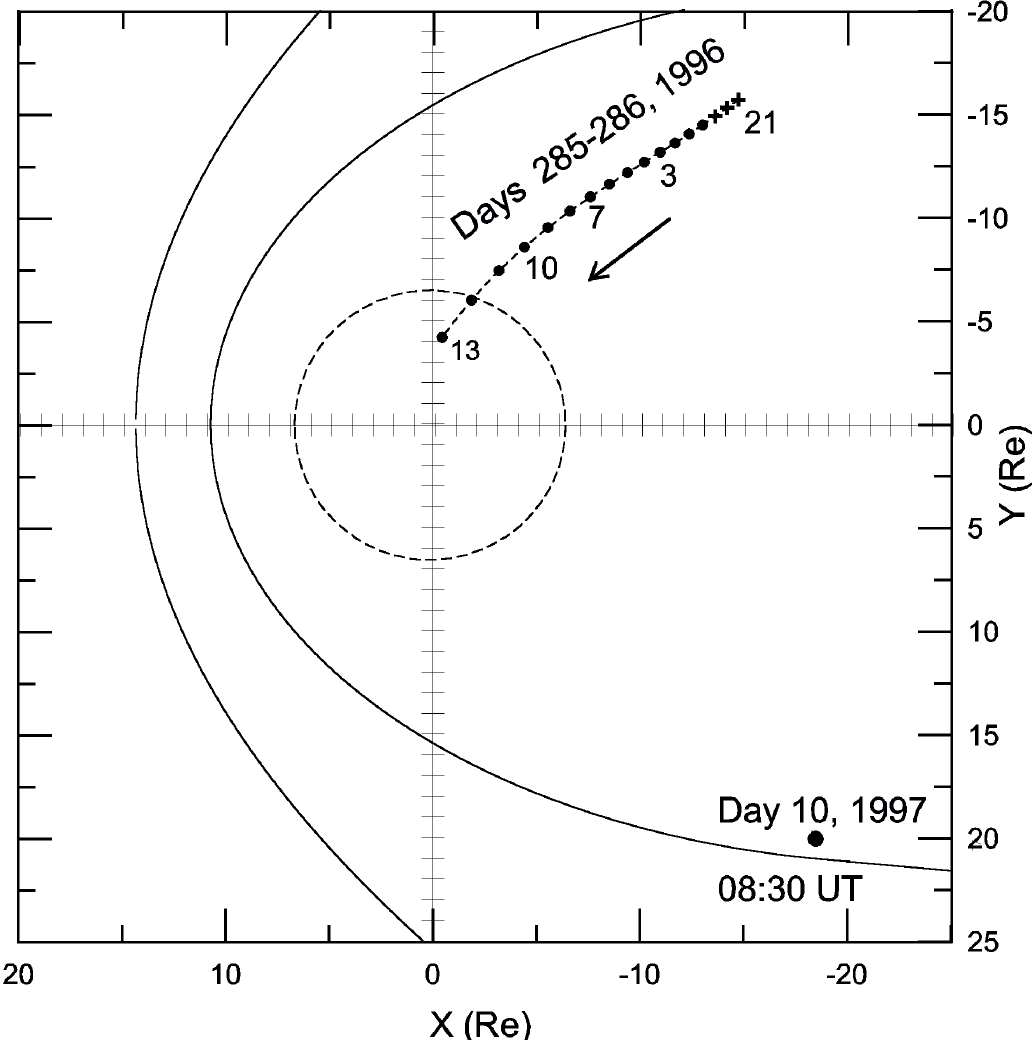
Fig. 2. Interball trajectory projected on the XY GSM plane and corresponding to the interval from 21:00 UT of Day 285 to 13:00 UT of Day 286, 1996, and Interball position at 08:30 UT of Day 10, 1997. Trajectory is divided by one symbol per hour. Average bow shock and magnetopause positions, as well as the GEO orbit (dashed line), are